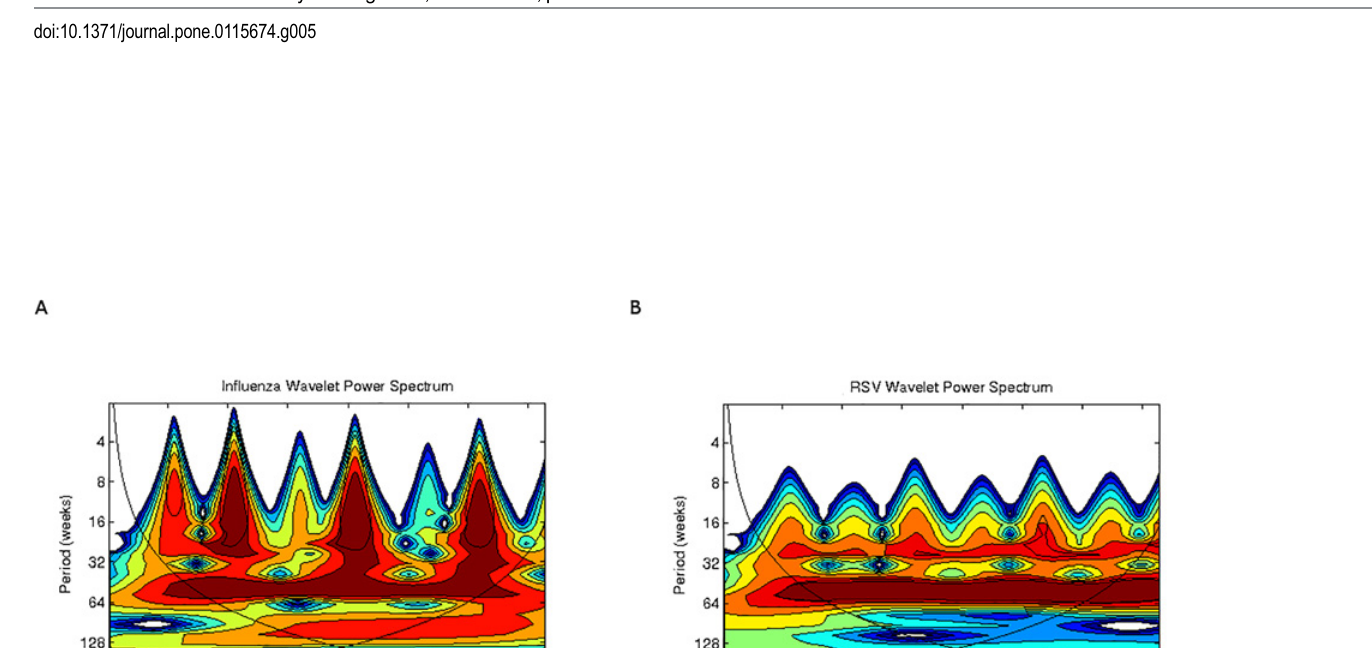
Fig 5. Scalograms (absolute values) for periods between 8 and 64 weeks (2003 – 2009). (A) Total influenza cases. (B) Total RSV cases. Horizontal axis, weeks numbered consecutively starting 2003; vertical axis, periods in weeks.